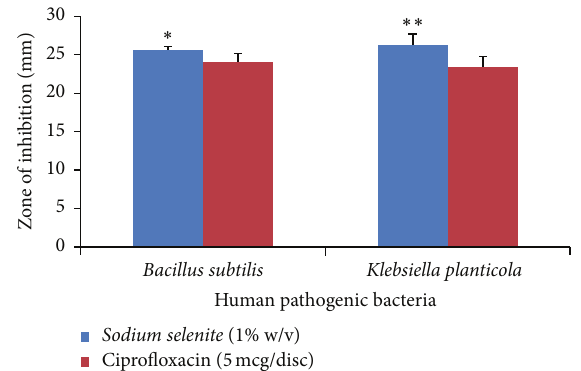
Figure 1: Significant spectrum of activity of sodium selenite when compared to standard ciprofloxacin, ∗ 𝑃 < 0.05 sodium selenite when compared to ciprofloxacin in Bacillus subtilis and ∗∗ 𝑃 < 0.01 sodium selenite when compared to ciprofloxacin in Klebsiella planticola